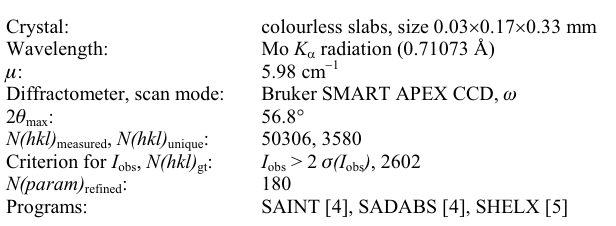
Table 1. Data collection and